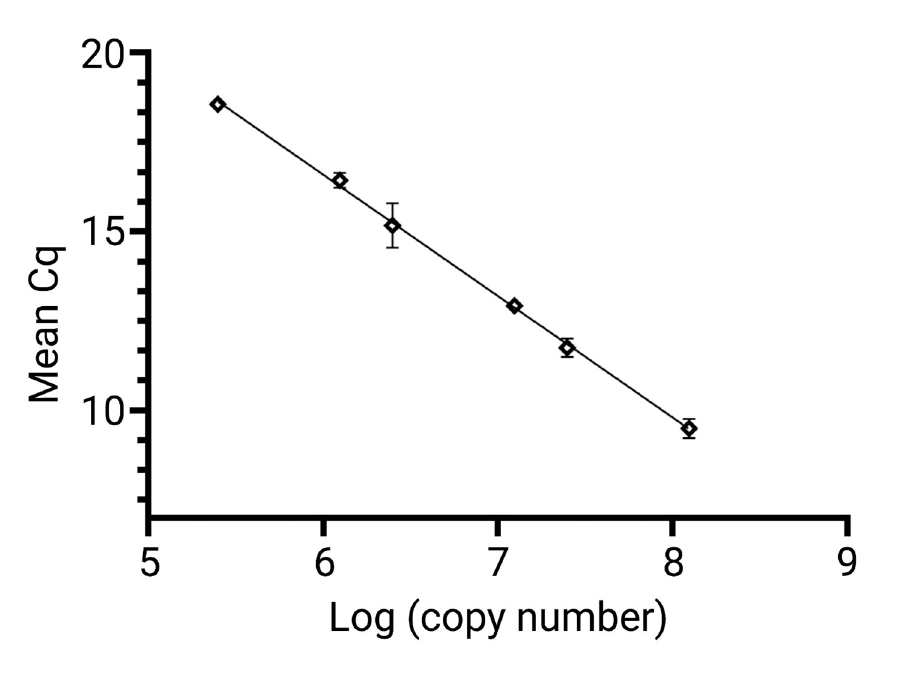
from 2.5 x 10 5 target copies/reaction to 1.25 x 10 8 target copies/reaction were run in nine to 11 replicate reactions. Mean Cq values and standard deviations were then calculated for all replicates containing each number of template copies, a slope was plotted, and both the reaction efficiency and amplification factor were determined.